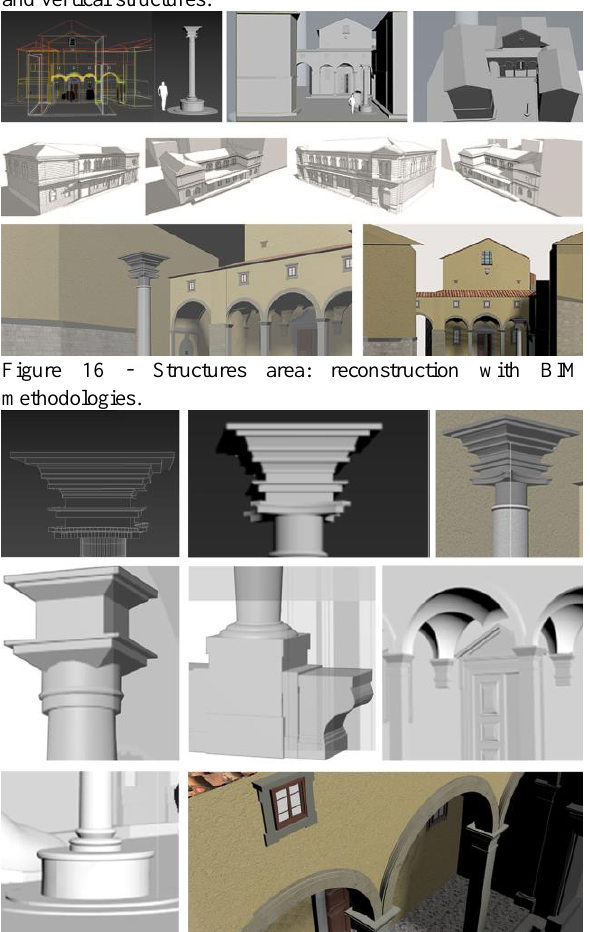
Figure 17 – Elements architecture recostruction with On- demorphogenesis and texture